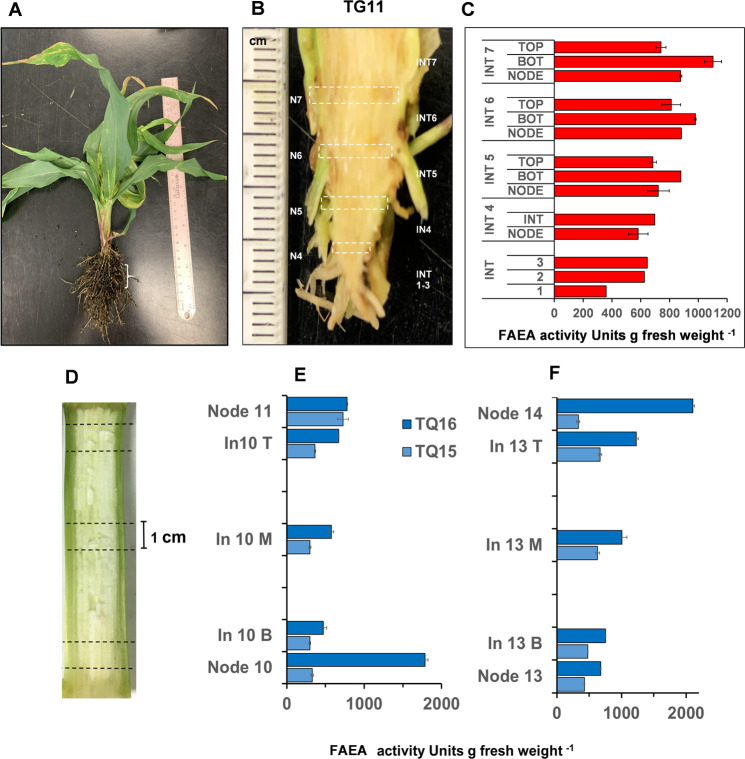
Distribution of FAEA activity in TG and TQ internodes.Dwarf mutant phenotype of plant TG11 at the V13 developmental stage (A), and the internode phenotype (B). FAEA activity levels in sections of fused internodes 1–3 and in nodes and internodes 4–7 (C) and FAEA activity in different regions of fully expanded internodes 10 of plant TQ15 and TQ16 (E,F) at the VR developmental stage and the internode phenotype (D).